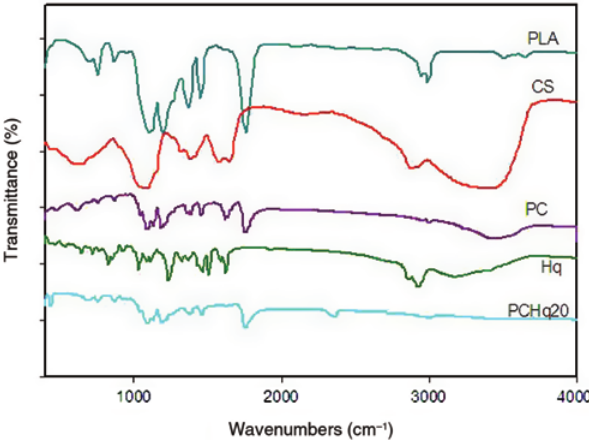
Figure 1: Fourier transform infrared spectra of hydroquinine (Hq), poly(lactic acid)/chitosan (PLA/CS) (PC), and PLA/CS/hydroquinine (PCHq)